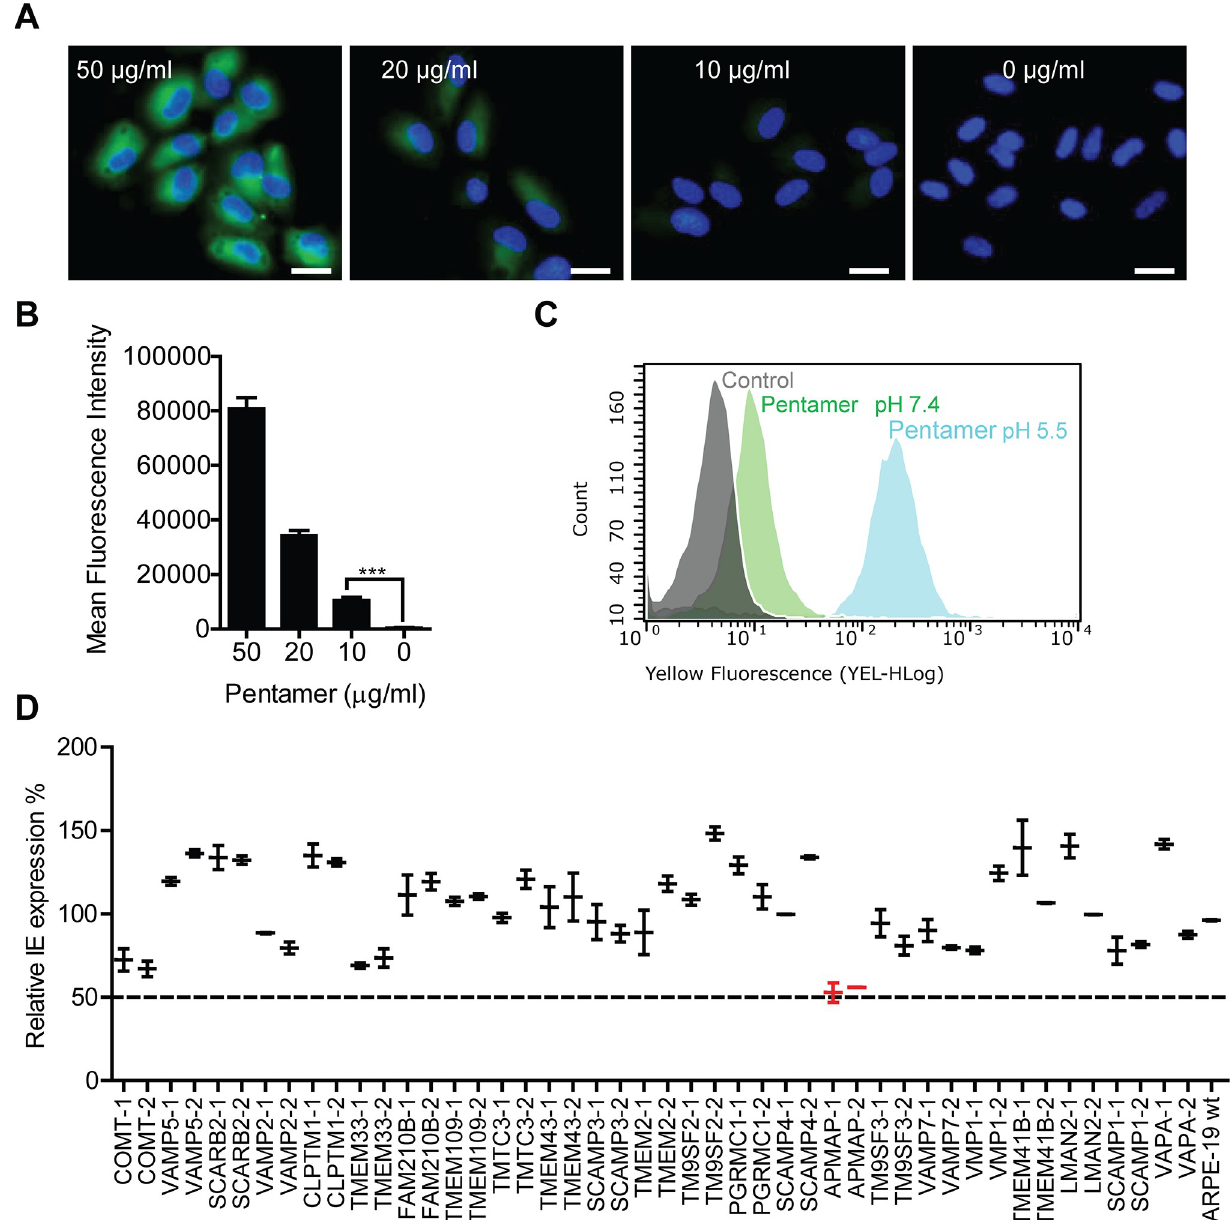
Fig 1. Interaction of HCMV pentamer with ARPE-19 cells. ( A ) AREP-19 cells grown in chamber slides were fixed by 4% PFA and blocked with 1% (W/V) BSA. Pentamer was diluted using 0.1% (W/V) BSA in PBS (pH7.4) at indicated concentrations and incubated with ARPE-19 cells for 1 h at 37˚C. The cells were washed 3 times to remove unbound pentamer before staining with FITC-conjugated anti-His-tag antibodies which recognize recombinant gH subunit of the pentamer. Nucleus was stained with DraQ5. The cells were imaged using a LEIKA confocal microscopy. Bar = 20 nm. ( B ) Quantitation of pentamer specific fluorescence intensity in panel 1A. The unpaired two-tailed student t-test was used for significance analysis. ( C ) Pentamer was incubated with ARPE-19 cells in suspension at a final concentration of 20 μ g/ml in either neutral pH (7.4) or low pH (5.5) buffer for 1 h on ice. After washing away of unbound pentamer, the cells were stained with FITC-conjugated anti-His tag antibodies and subjected to flow cytometry analysis. Cells incubated in buffer without pentamer but stained with the FITC-conjugated anti-His tag antibodies served as a negative control. ( D ) Top 23 candidate membrane proteins were knocked out (K/O) in ARPE-19 cells using the CRISPR/Cas9 system. These proteins were identified as candidates for pentamer binder at low pH by Pull-down/Mass spectrometry assay. The stable K/O cells were infected with HCMV strain AD169rev at MOI = 0.1 for 24 h and then subjected to IE protein staining by In-cell western assay. Data were shown as the percentage of IE signal in the K/O cells to that of infected wildtype ARPE-19 cells. The bars represent means ± SD of replicate wells. The data shown are representative results of three independent experiments.